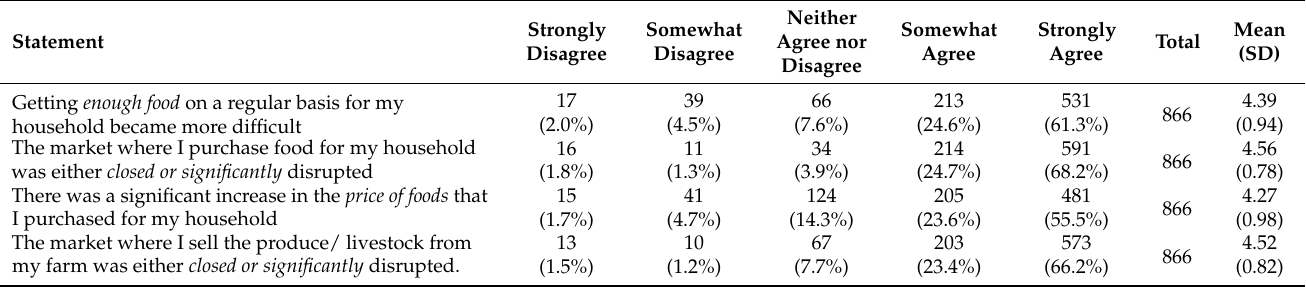
Table 13. Thinking about what occurred due to COVID-19, please indicate your one best response to the following statements.